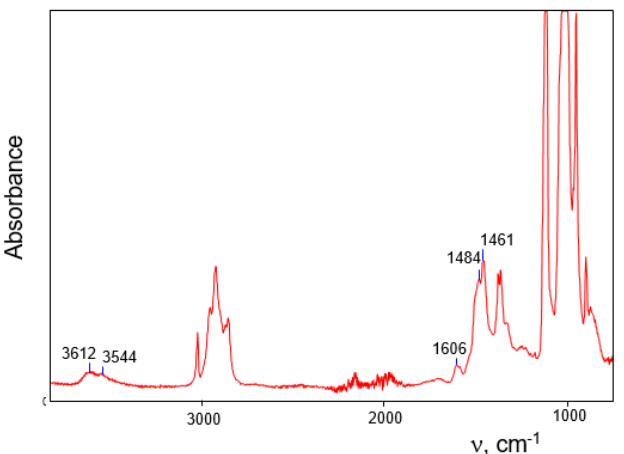
Figure 8. The IR spectrum of a set of i -C 4 H 7+ (Cl 11 − ) crystals and ( i -C 4 H 7+ · OH 2 )(Cl 11 − ) crystals cocrystallized with them. Table 5. IR frequencies of H 2 O molecules bonded to cations through O-atom.